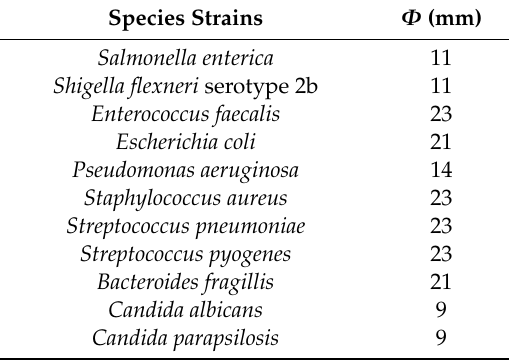
Table 6. Antimicrobial activity of